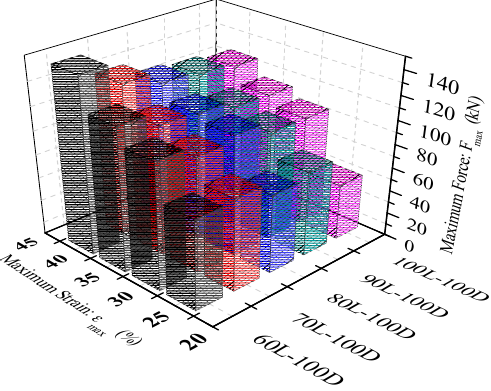
Figure 13. Relationships between maximum strain and maximum force. Table 4. Regression between maximum strain and force in Type 2 specimens.